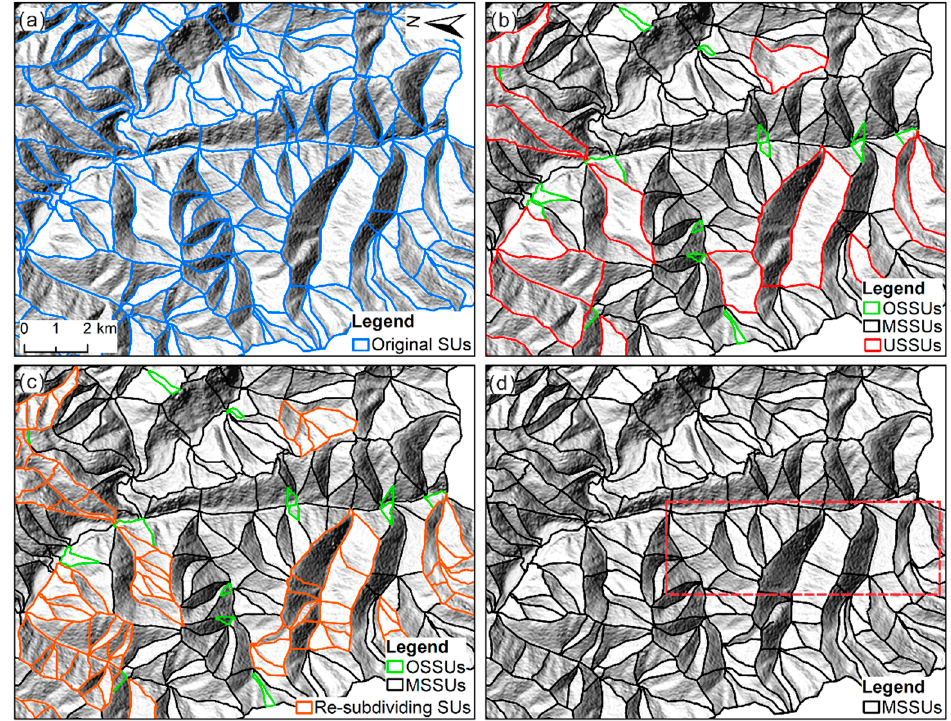
Figure 10. Gradual optimization process by the proposed method. ( a ) are the original SUs at optimal scale of (100, 0.3). ( b ) are the classification for the original SUs before refining. ( c ) are the first operation of replacing the USSUs with finer scale of (100, 0.2). ( d ) is the final MSSUs after refining unrealistic SUs. Table 5. Statistical table of gradual optimization process from OSSUs and USSUs to MSSUs.